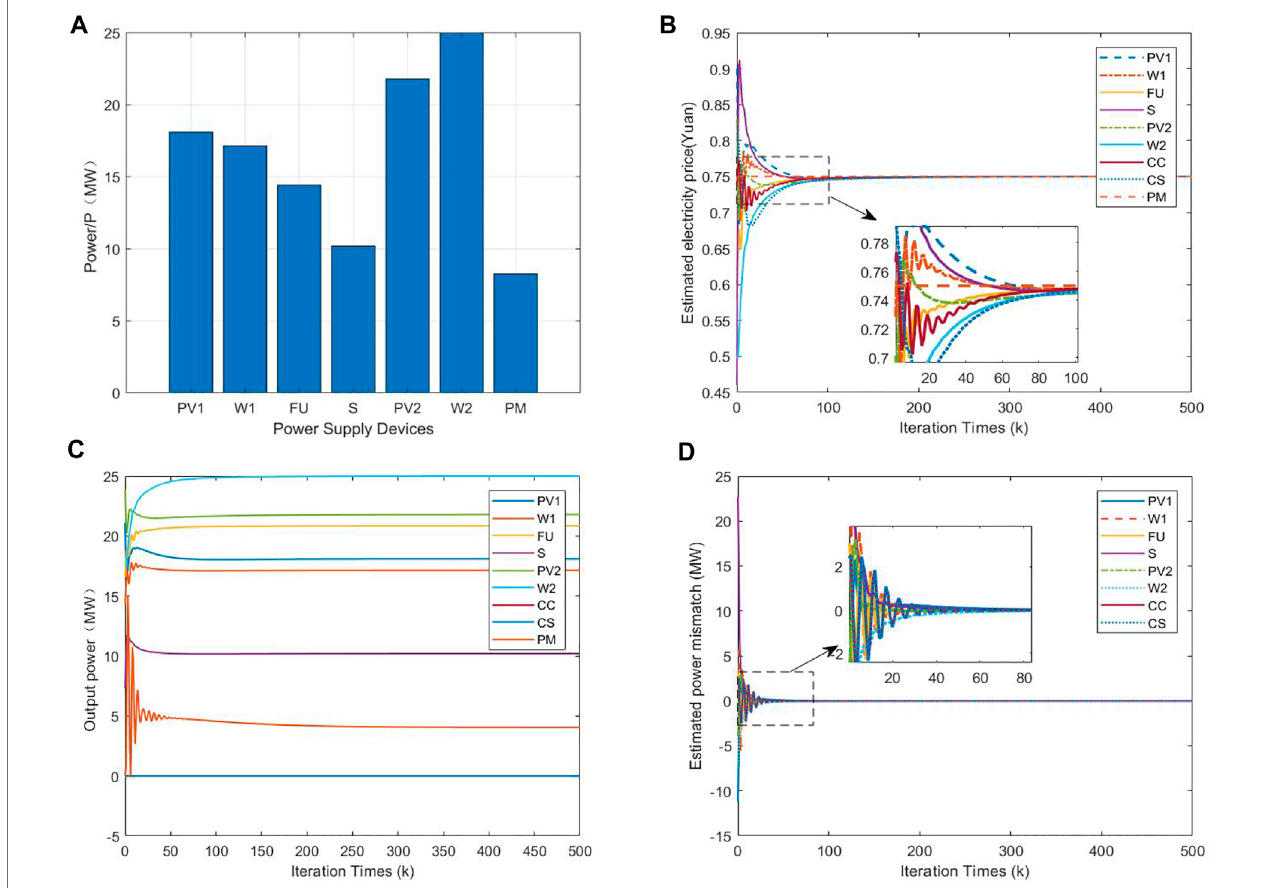
FIGURE5 | Simulation results ofpower purchase from the main grid in grid-connected mode. (A) is theresults ofcentralized algorithm, (B) is thedynamiccurveof the electricity price λ , (C) is the dynamic curve of the power output, (D) is the dynamic curve of the estimated power.